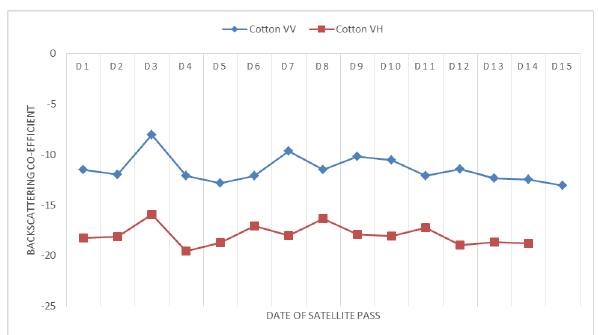
Figure 4. Mean temporal back scattering of Cotton The minimum, maximum and mean temporal backscattering signature for Vertical-Vertical (VV) and Vertical-Horizontal (VH) polarized SAR data for cotton and maize were